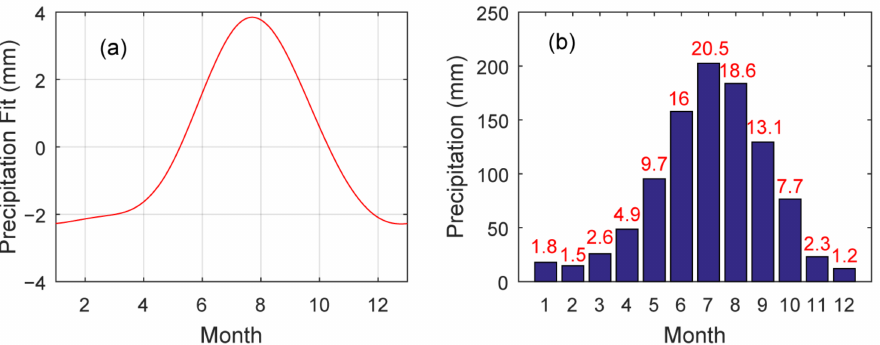
Figure 6. Annual average results of precipitation superimposed on 24 stations. ( a ) Annual and semi-annual seasonal terms extracted by Morlet wavelet transform. ( b ) Monthly average value of precipitation and percentage of annual